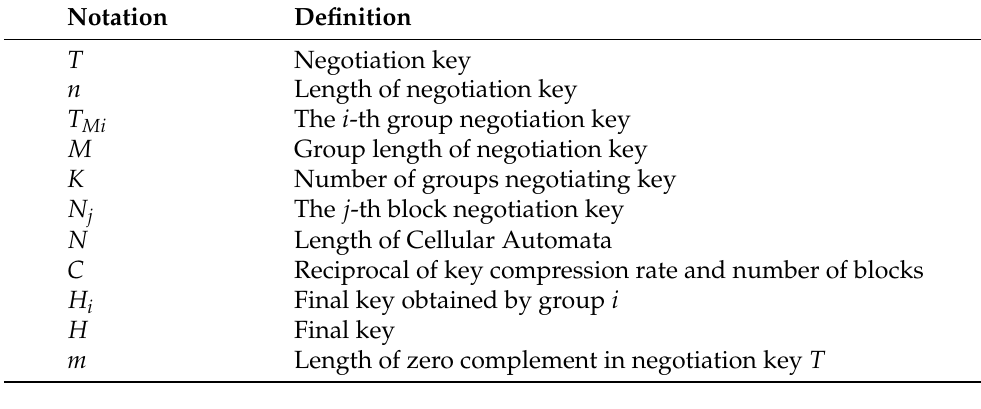
Table 2. Notations.